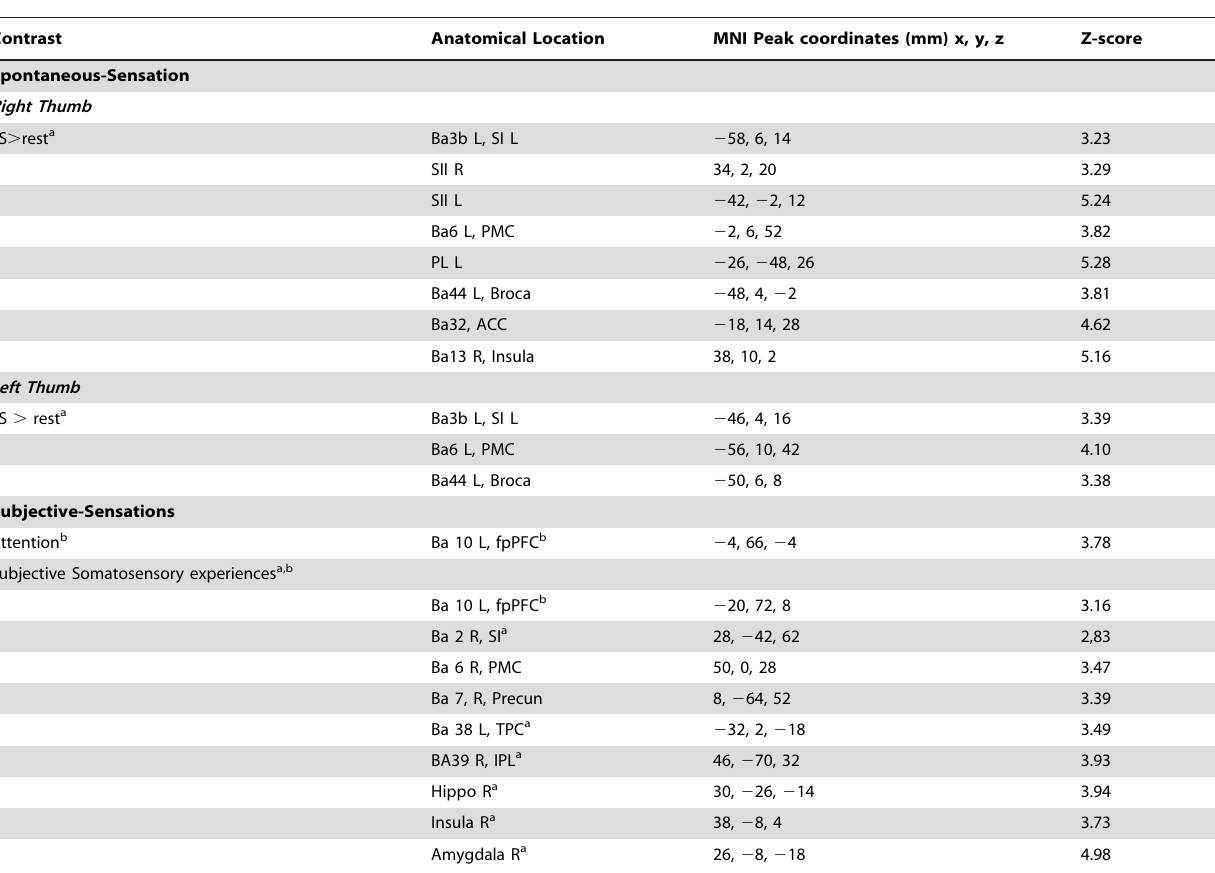
Table 2. Peak voxel activation for all experiments.